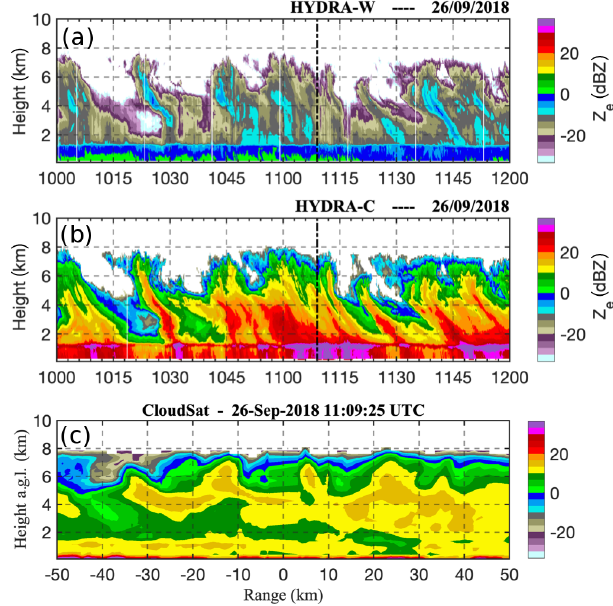
Figure 24. Observations of clouds and precipitation using Hyytiälä (a) cloud, ( b) precipitation radars, and (c) CloudSat cloud profil- ing radar. The vertical dash-dotted line in the panels indicates the CloudSat overpass time. The x axis in the CloudSat panel shows the distance between the Hyytiälä site and the satellite ground track. Simulated concentrations of BC tracer with a 5d lifetime (µgm − 3 ) (a) along the YAK flight on 15 October 2014 (flight altitude also given, white line) and (b) at the surface at 05:00UTC on 15 Oc- tober 2014; flight tracks are also shown. BC tracer concentrations are normalized to the total BC emissions from Huang et al. (2015) over the model domain and emitted based on annual mean flaring locations using VIIRS